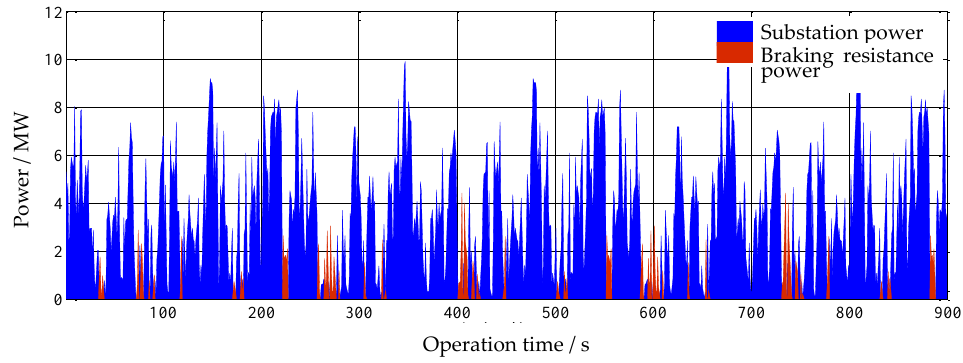
Figure 16. Total output power of traction substation and absorption power of braking resistance after dwell time optimization.